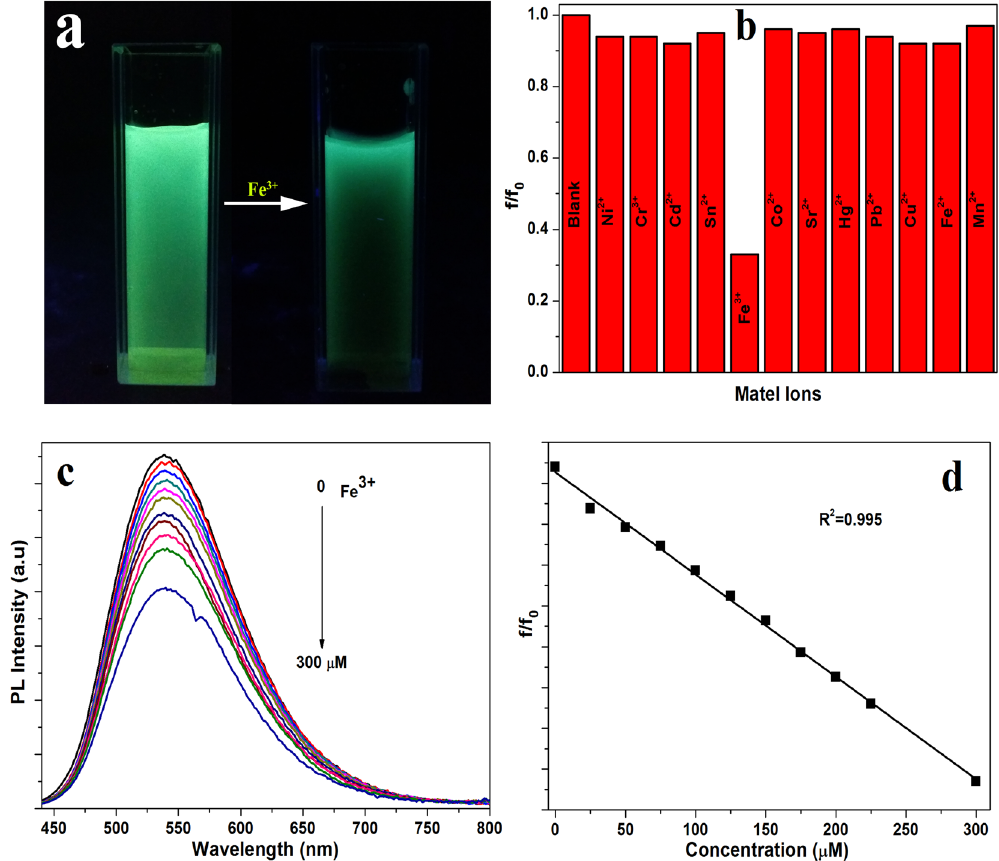
Figure 5. ( a ) photographs of the green-emitting CDs without and with Fe 3 + ions under 365 nm UV lamp irradiation. ( b ) Emission intensity of the green-emitting CDs after adding different metal ions with same concentration. ( c ) The photoluminescence spectra of green-emitting CDs with different concentration of Fe 3 + from 25 to 300 µ M. ( d ) The dependence of f/f 0 on the concentration of Fe 3 +